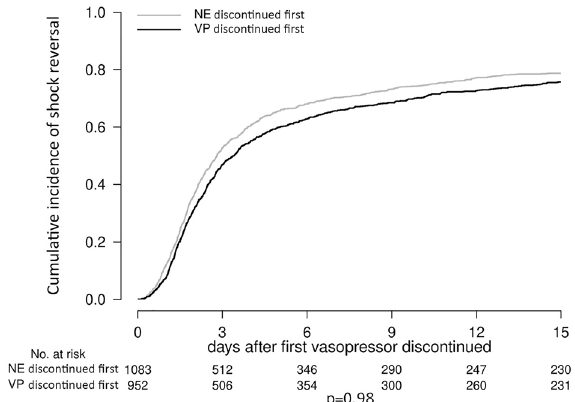
Figure 3. Cumulative incidence of shock reversal following first vasopressor discontinuation by order of vasopressor